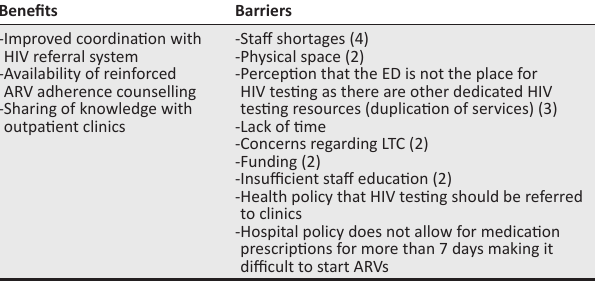
TABLE 3: Opportunities and barriers to emergency department–based HIV